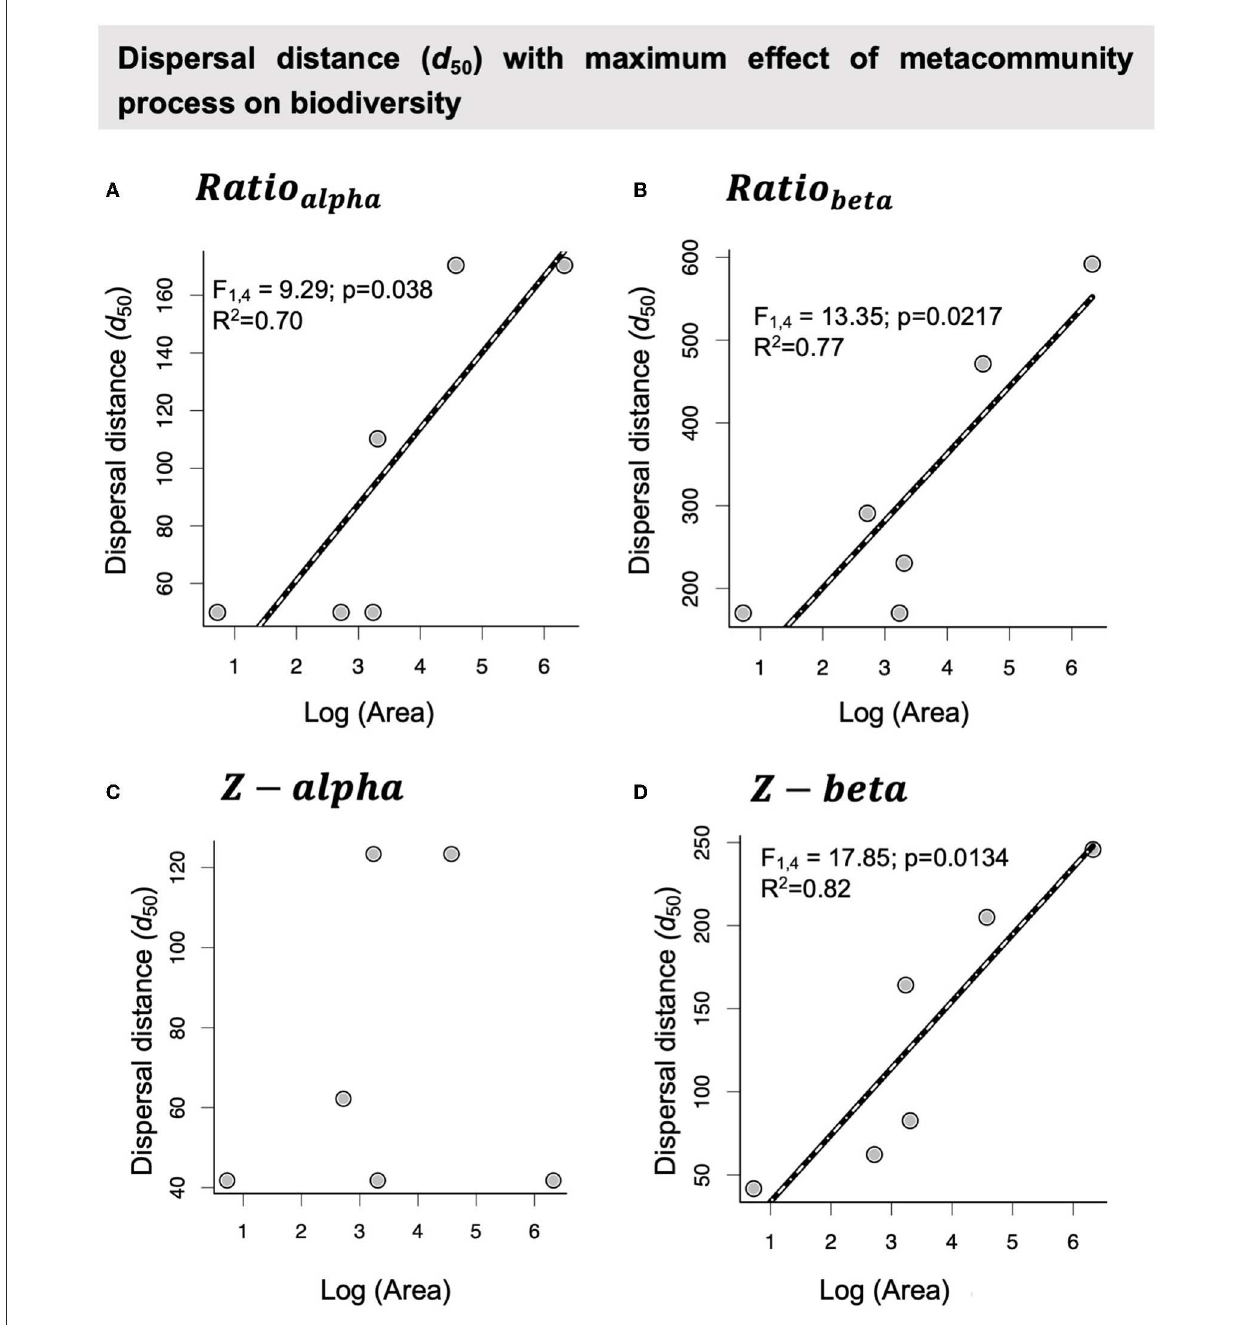
FIGURE4 Effect of pondscape spatial extent (total area) on the interplay between the diversity of local communities, species dispersal ability ( d 50 ), and patch geographic isolation among the six metacommunities considered. (A, B) Relationship between the dispersal distance at which the maximum Ratio alpha ( minimum Ratio beta ) occurs and the area of the pondscape. (C, D) Relationship between the dispersal distance at which the maximum Z − alpha ( minimum Z − beta ) occurs and the area of the pondscape. Relationship between the dispersal distance ( d 50 ) at which the maximum effect of the spatial arrangement of waterbodies on Ratio alpha and Ratio beta and the area of